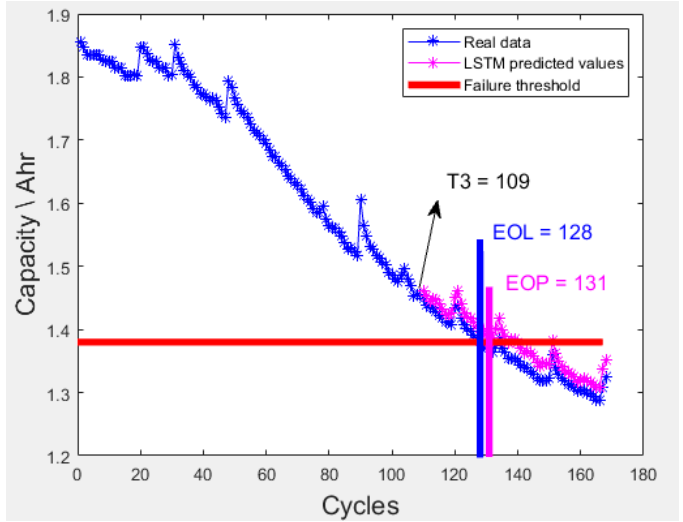
Figure 10. The predictions result of LSTM at T3 = 109.